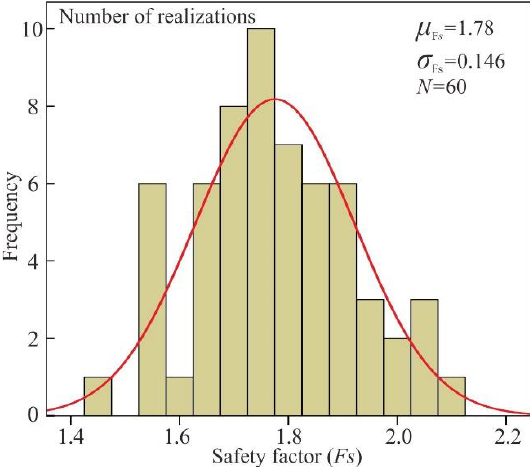
Figure 5. Influence of the number of realizations on Fs  and Fs  (a-the fluctuation of Fs  with N increases; b-the fluctuation of Fs  with N increases).